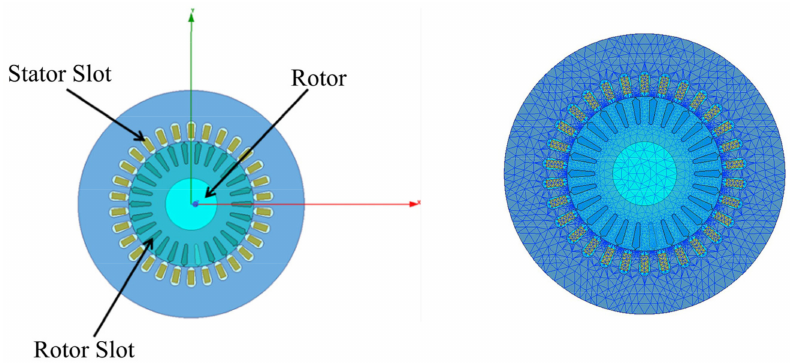
Figure 3. Electromagnetic field calculation